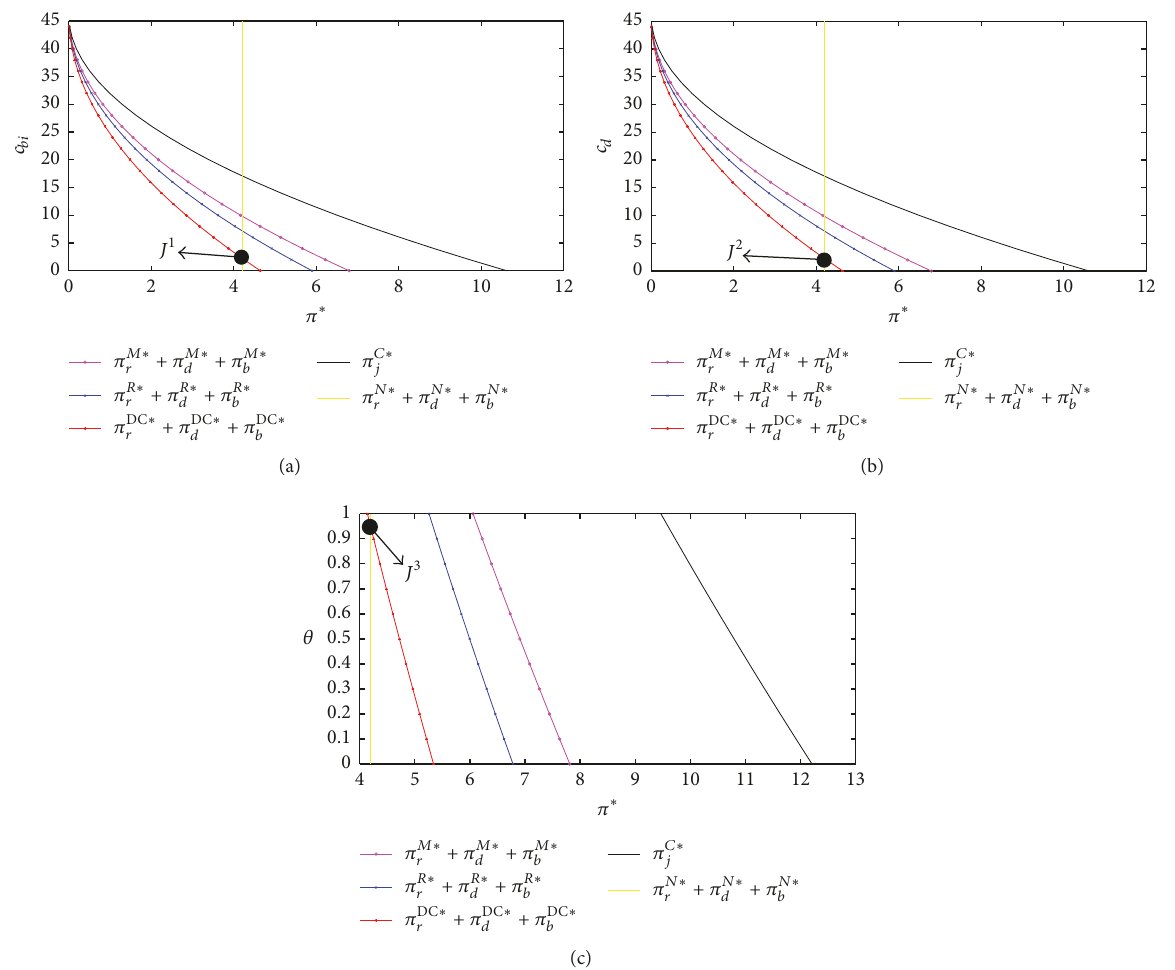
Figure 8: Effects of 𝜃 , 𝑐 𝑏𝑖 , and 𝑐 𝑑 on benefits of the entire supply